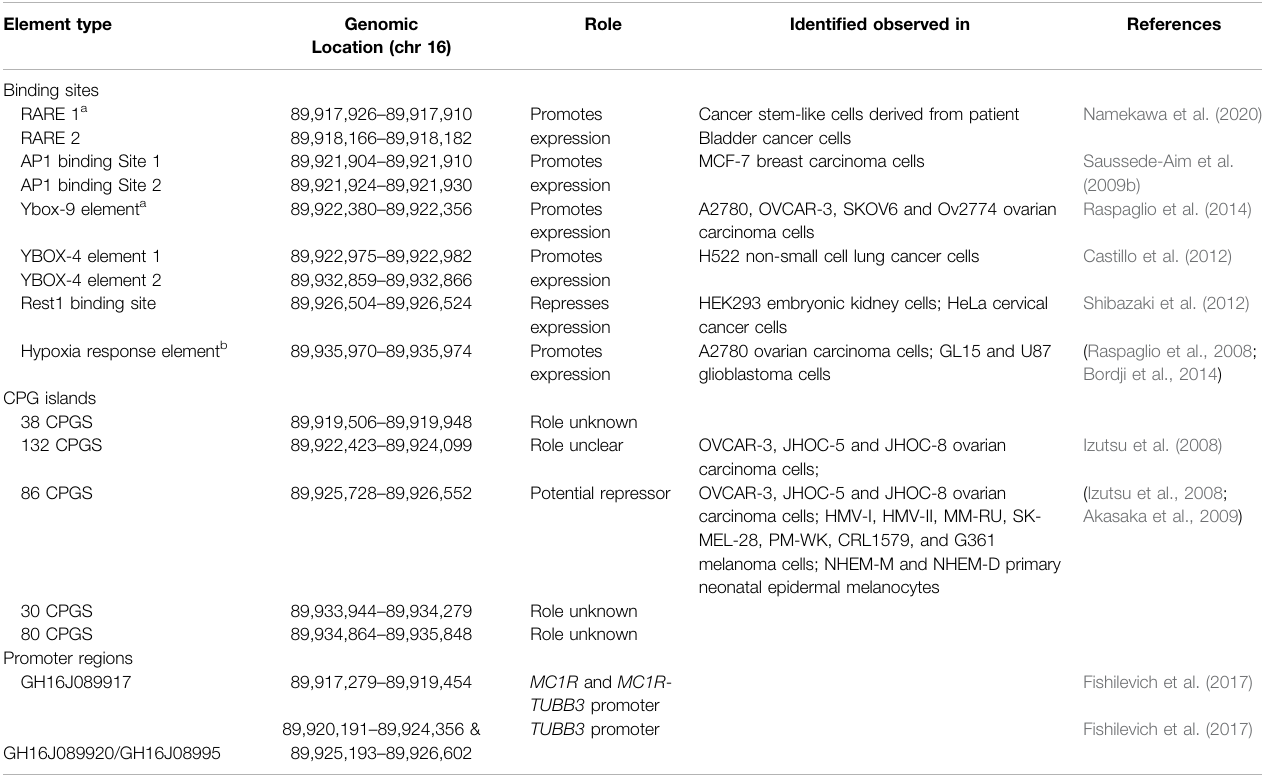
TABLE 2 | Validated genomic binding sites within the human TUBB3